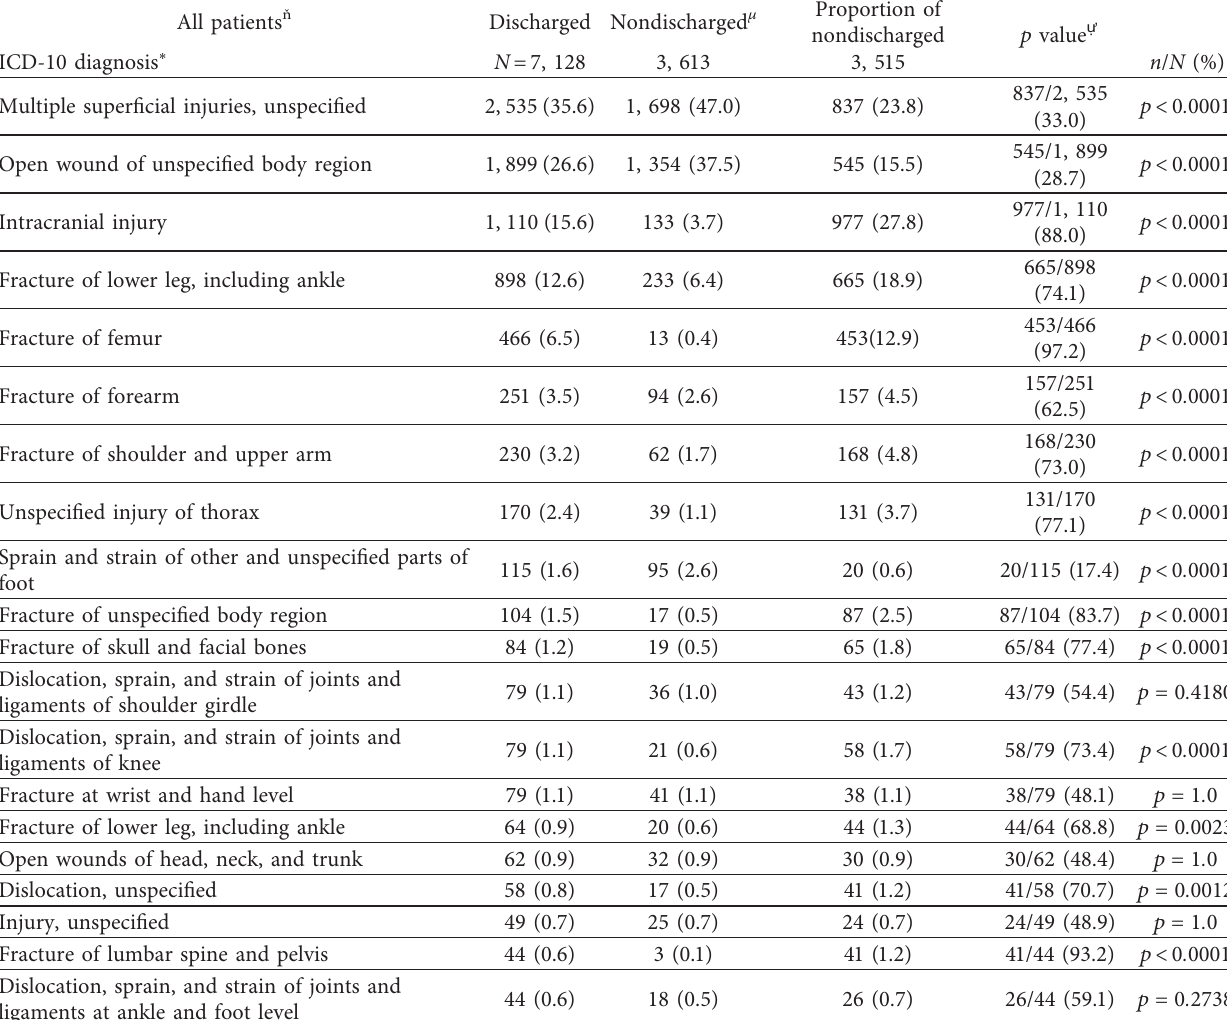
Table 3: ICD-10 diagnosis and final EU disposition.